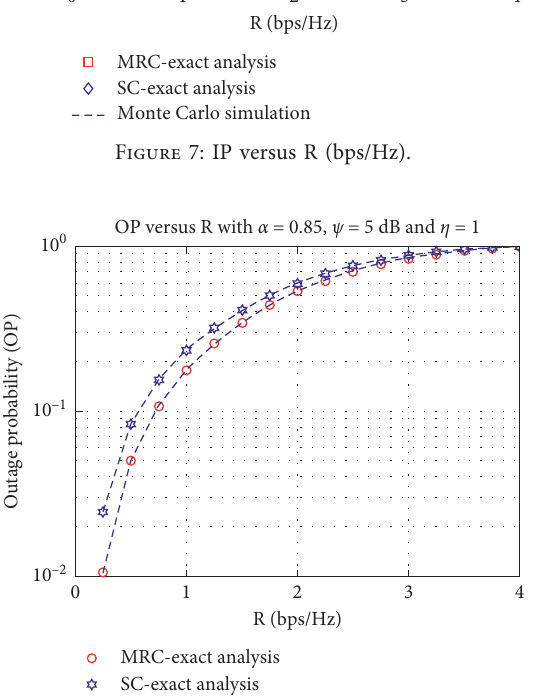
Figure 8: OP versus R (bps/Hz).